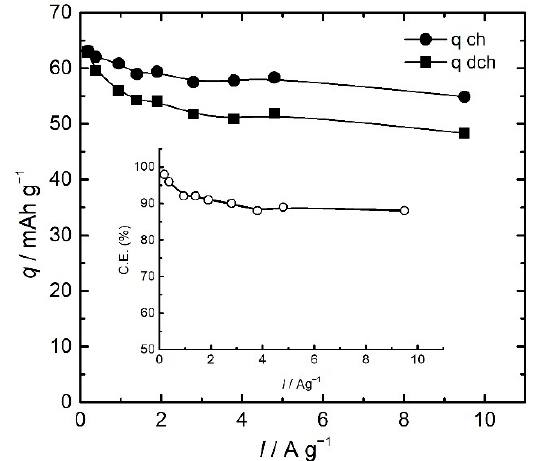
Figure 8. The dependence of charge, q ch , and discharge, q dch , capacity on specific current. Insert: Coulombic efficiency over specific current.